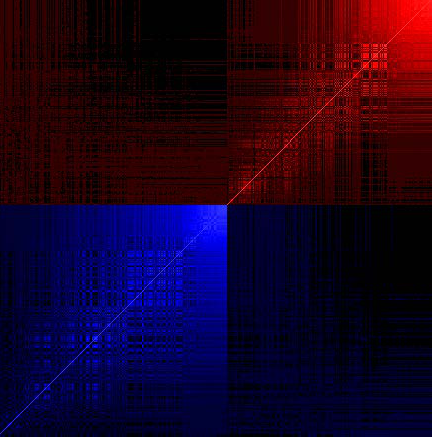
Figure 9. Proximity matrix map of 660 cases in the training database.